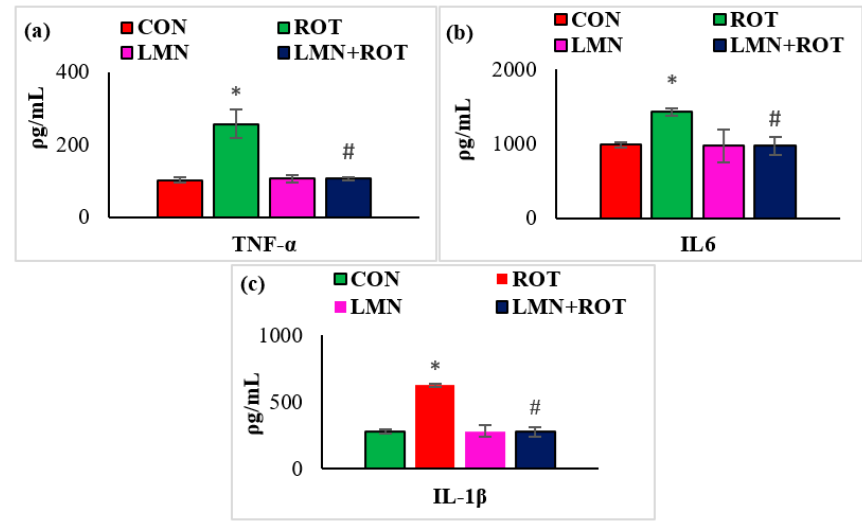
Figure 5. Effect of limonene on the concentration of proinflammatory cytokines (TNF- α , IL-6, and IL-1 β ) in the midbrain of rats ( a – c ). The values are presented as mean ± SEM (n = 6–7); * p < 0.05 CON vs. ROT; # p < 0.05 ROT vs. LMN + ROT (one-way ANOVA followed by DMRT). CON: normal control, ROT: rotenone, LMN: limonene, LMN + ROT: limonene and rotenone treatment.